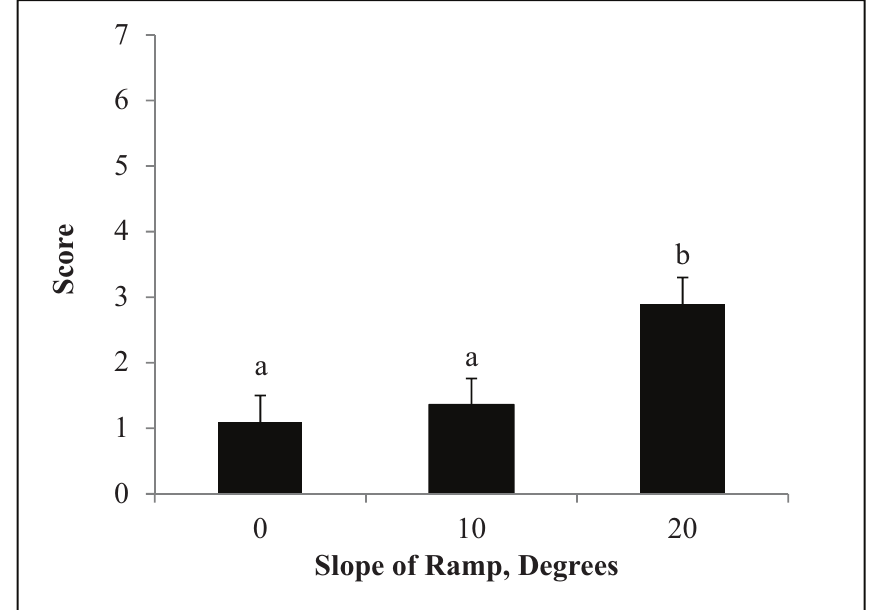
Figure 3. Least Squares means for weaned pig scores at different ramp slopes ( P < 0.01). Scores were calculated based on the sum of slips, falls, and vocalizations. n = 300 observation of 20 pigs